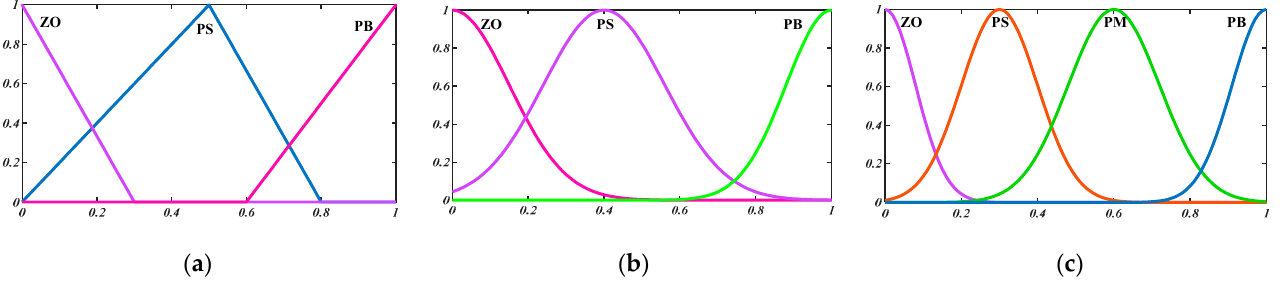
Figure 5. Membership functions of inputs and outputs: ( a ) the membership function of k y ϕ , ( b ) the membership function of k βω , and ( c ) the membership function of the outputs.